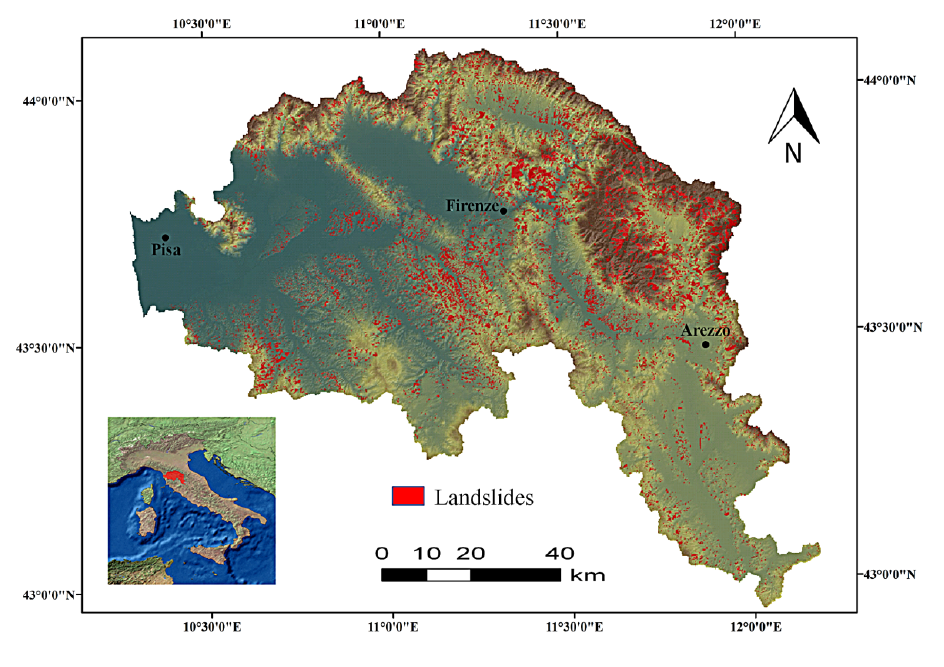
Figure 1. The geographical location and landslide distribution in the Arno River